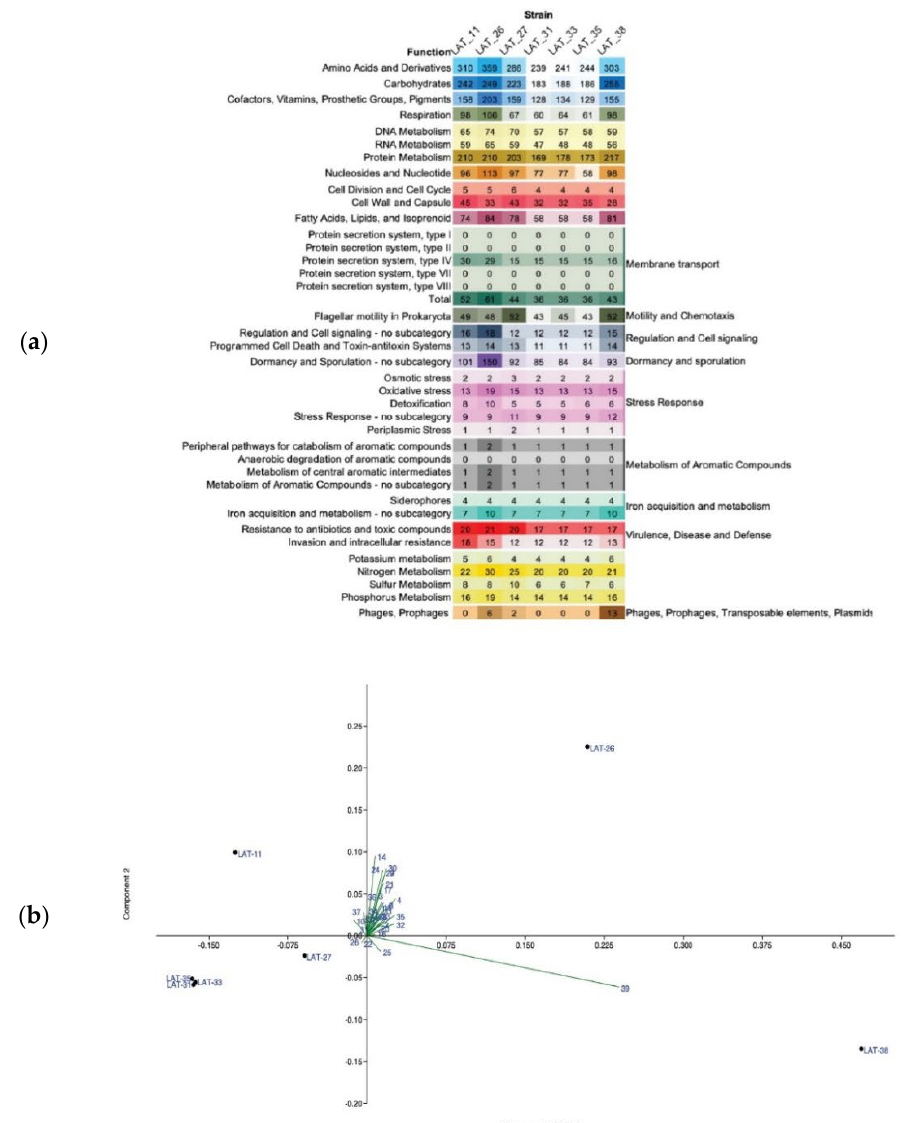
Figure 4. Functional analysis of Anoxybacillus strains described in the present study. ( a ) Number of genes related to metabolic functions in Anoxybacillus strains. ( b ) PCA plot of the annotated functional categories in Anoxybacillus strains; the Anoxybacillus strains are represented by dots, and the functional categories are represented by numbered green vectors. The angles and lengths of radiating vectors indicate the direction and strength of the relationships between the function and strain, respectively.